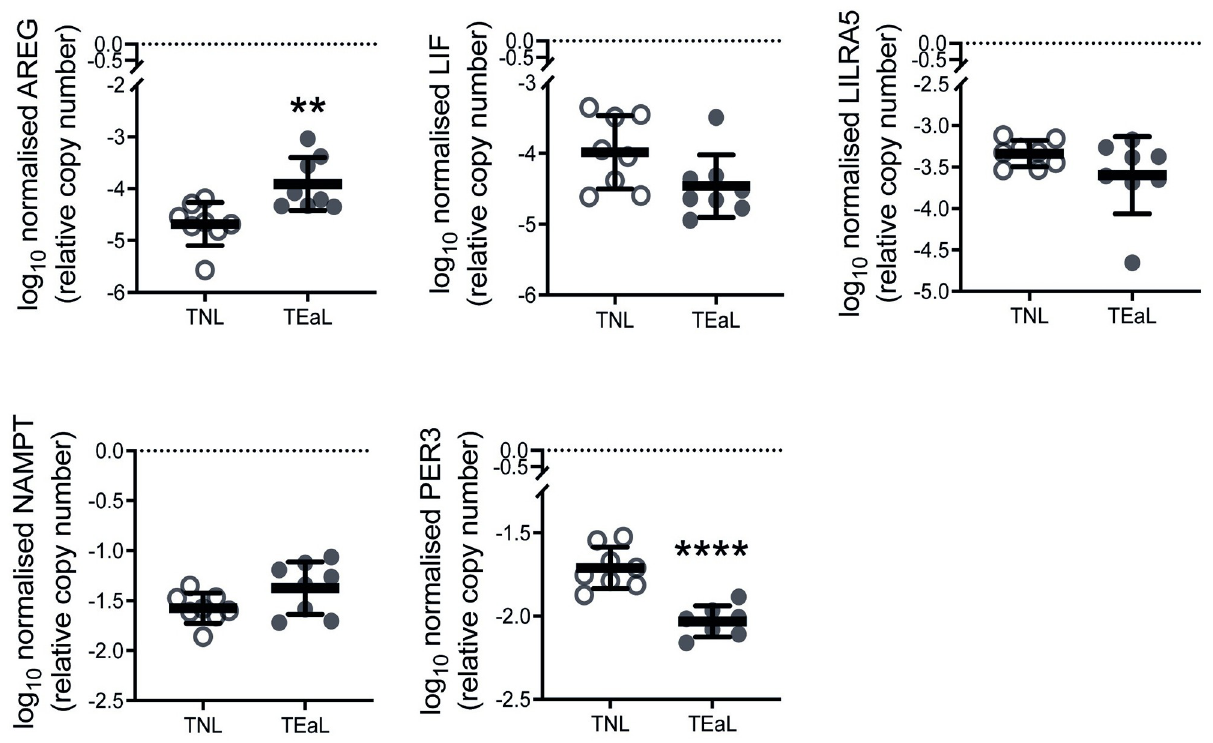
Fig 4. Relative mRNA abundance determined by qPCR for transcriptomics-identified myometrial DEGs common to TEaL in second cohort tissues. Log 10 transformed qPCR data (mean with standard deviation; n = 7–8) for myometrial mRNA levels of genes identified by RNA-seq (Fig 2) to be differentially expressed (DEGs) during early phase labour (defined as � 3 cm cervical dilatation; TEaL), when compared to the non-labouring state (TNL), in biopsies obtained from a cohort of term gestation singleton pregnant women separate to those in the RNA-seq cohort. All data for DEGs of interest were normalised to both β 2-microglobulin ( B2M ) and ribosomal protein L19 ( RPL19 ). Two-tailed Welch’s t -test was used for statistical analysis of TEaL vs TNL ( �� p � 0.01, ���� p �